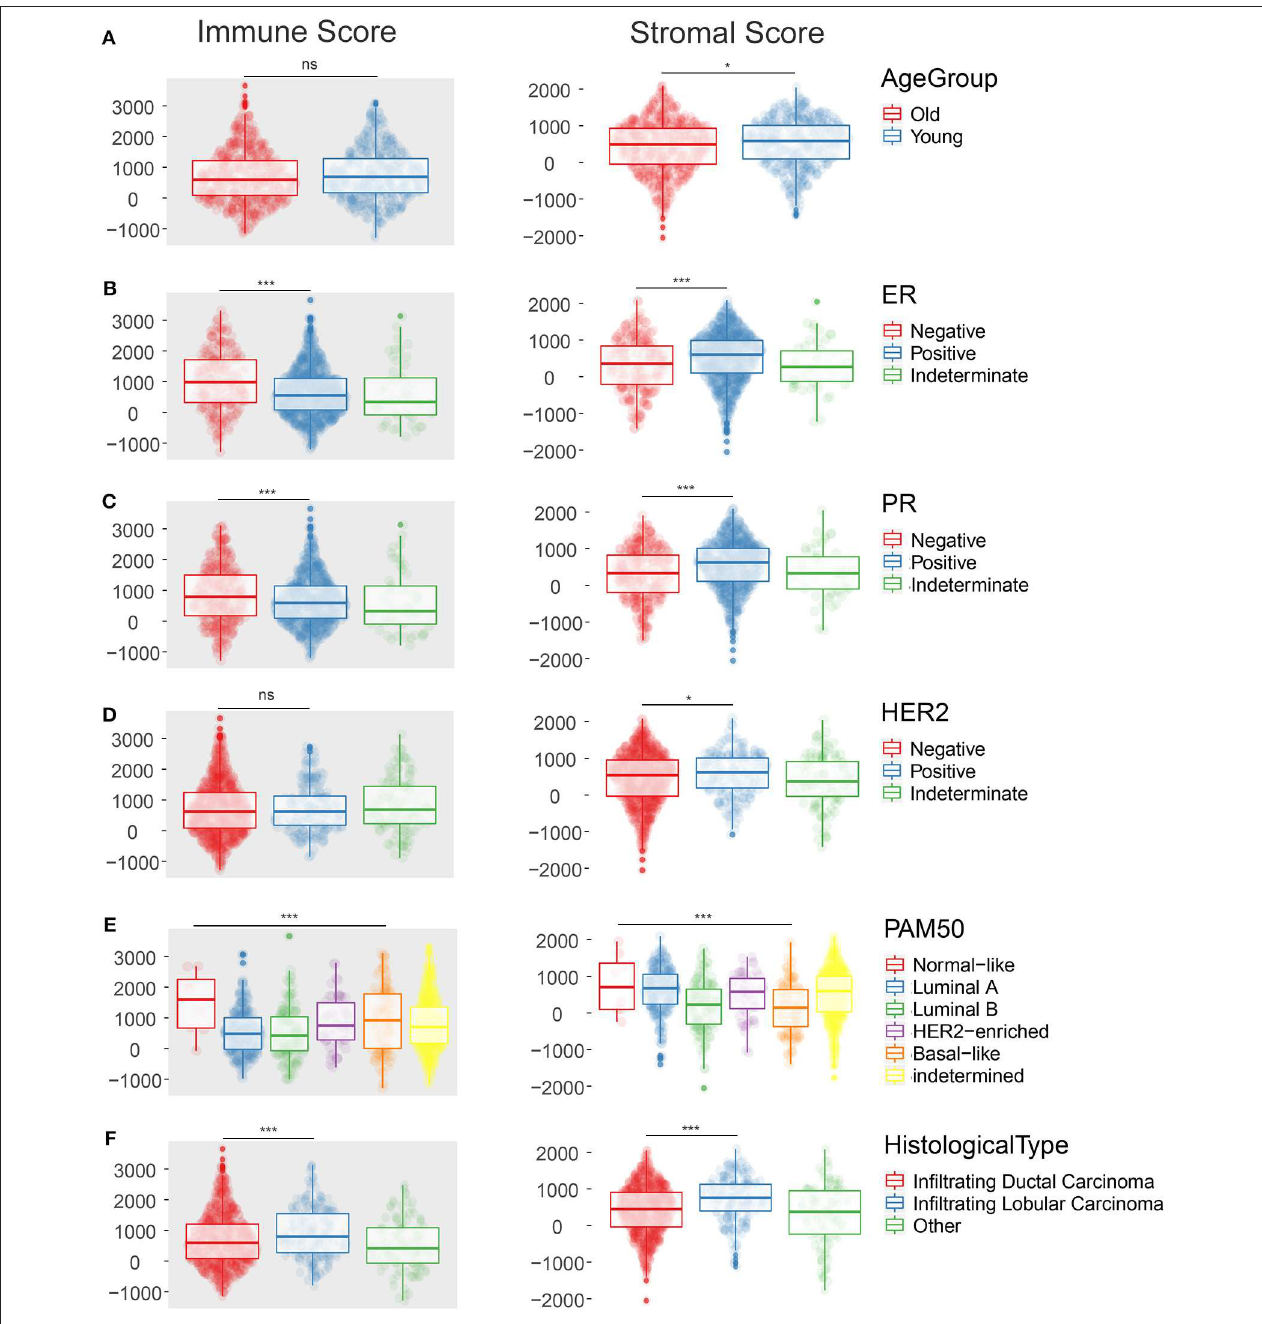
FIGURE 1 | The scatter plot shows that the immune score and the stromal score are distributed differently among clinical characteristics such as Age at diagnosis (A) , ER status (B) , PR status (C) , HER-2 status (D) , PAM50 subtypes (E) , Histological type (F) . * p < 0.05; *** p < 0.001; ns, not significant.